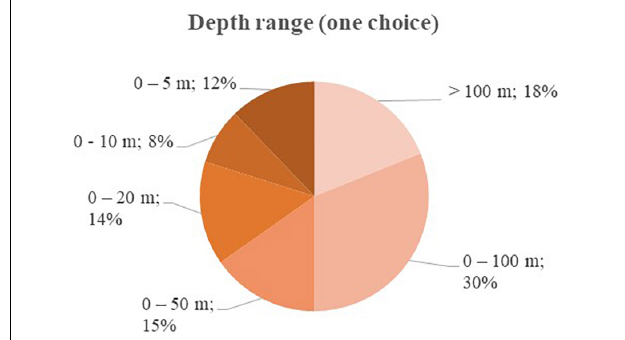
FIGURE 11 | Depth range of interest for surveyed users. Note that depth ranges are not necessarily independent and can overlap.